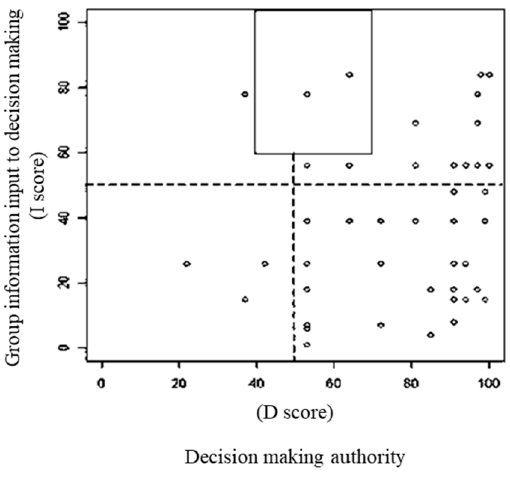
Figure 6. Determining the position of engineers on the DI diagram (Figure 1).